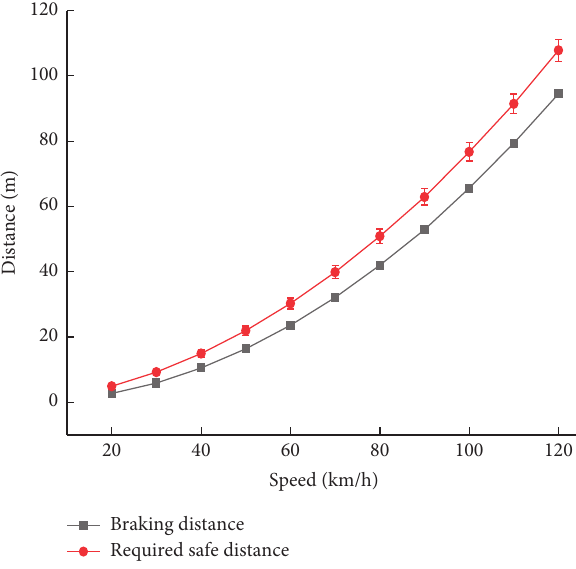
Figure 7: Corresponding relationship between vehicle speed’s and required safe distance. Table 1: Parameter calibration results of molecular following